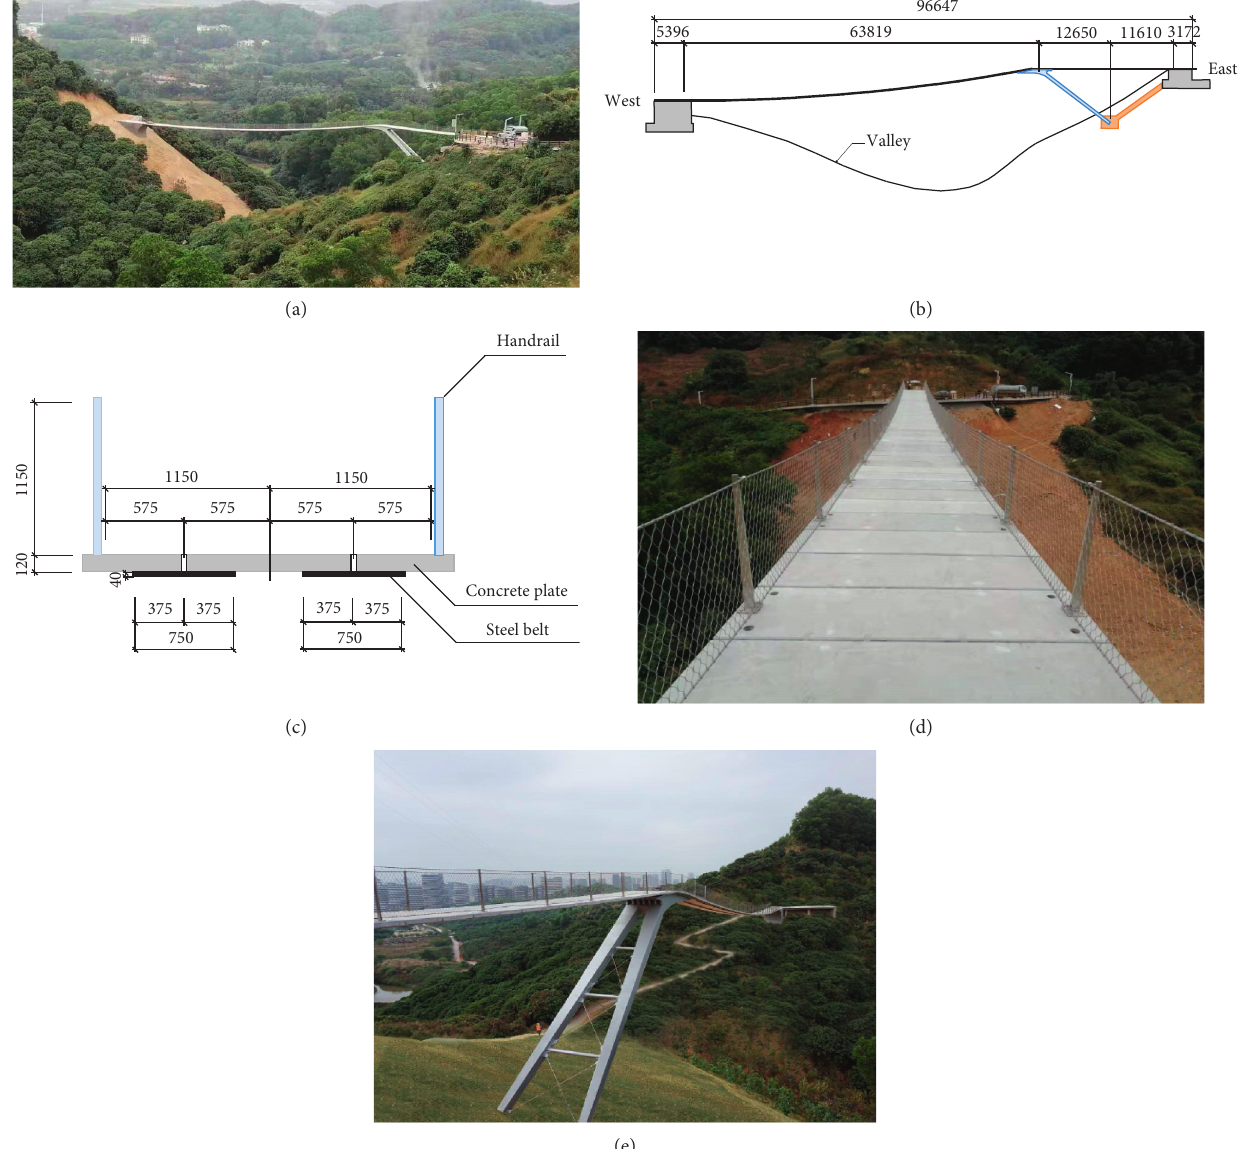
Figure 1: Schematic view and real pictures of the test bridge. (a) Real photograph, (b) elevation, (c) cross section, (d) bridge deck, and (e) columns. All dimensions are in